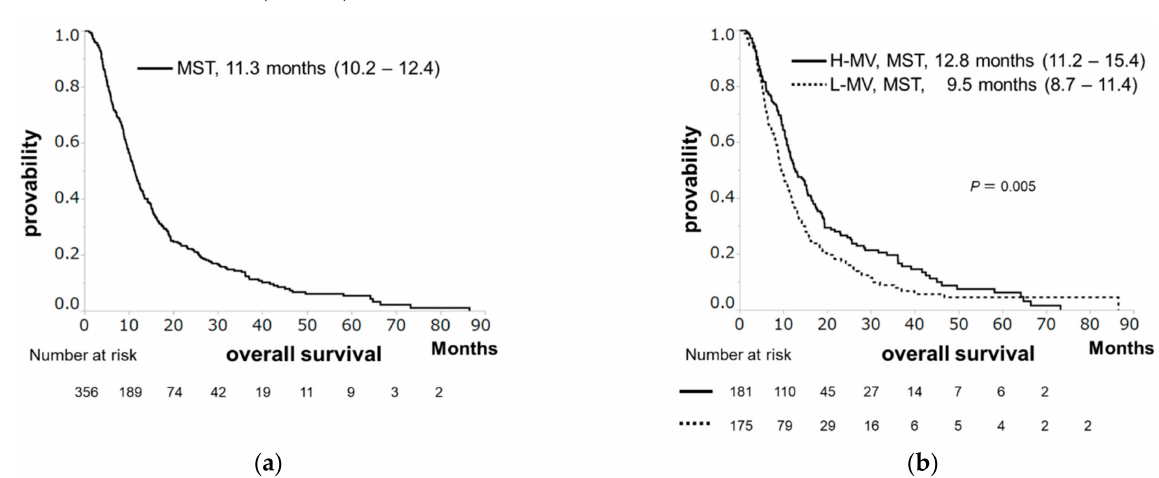
Figure 1. Overall survival (OS) in hepatocellular carcinoma patients receiving sorafenib. ( a ) The OS rates at 1, 2, and 3 years are 46.5%, 22.2%, and 13.9 %, respectively, with a median survival time (MST) of 11.3 months. ( b ) OS according to skeletal muscle volume. Patients with high muscle volume (H-MV) showed significantly longer survival than those with low muscle volume (L-MV) (MST: 12.8 vs. 9.5 months, p = 0.005).